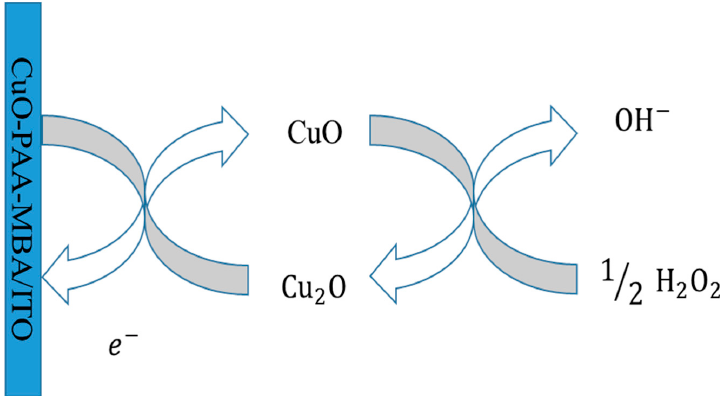
Figure 11. A plausible mechanism for the electrocatalytic reduction of H 2 O 2 at the CuO-loaded ITO